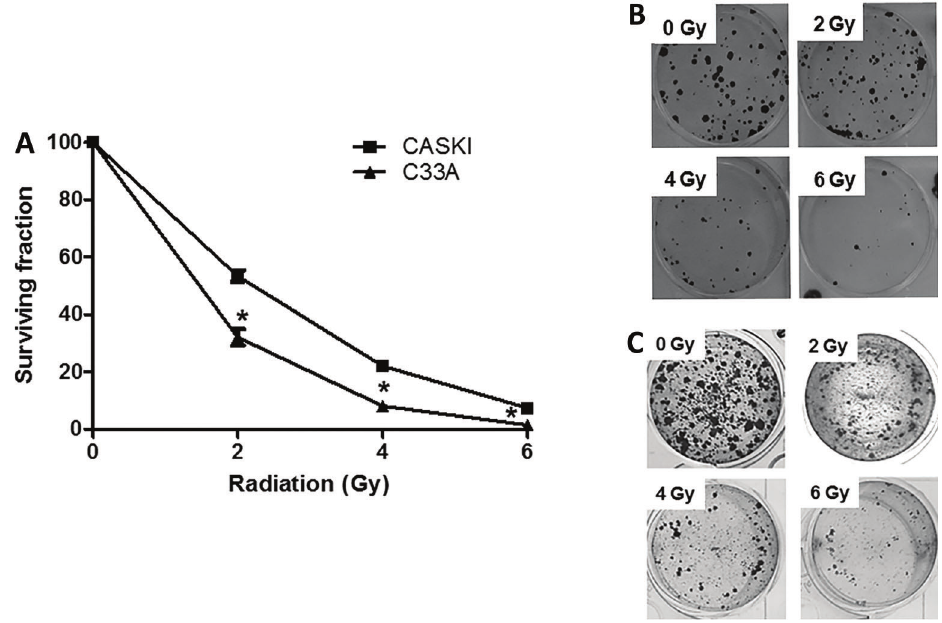
Figure 1 . Radiosensitivity pro fi le of cervical cancer cell lines. A , Cells were irradiated (2, 4, and 6 Gy) and incubated for 72 h. Then, cells were washed and allowed to proliferate in fresh medium for 10 more days. The number of colony-forming units in treated cultures is reported as the surviving fraction. *P o 0.05 (two-tailed unpaired t -test). Representative images of CASKI cells ( B ) and C33A ( C ) cells under different doses of